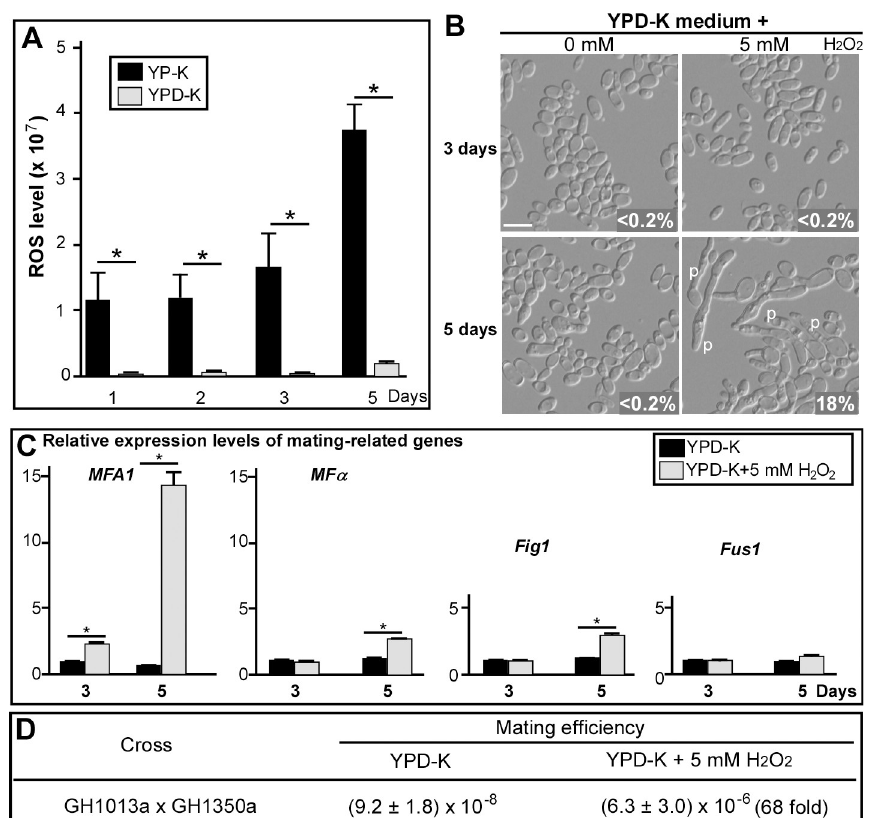
Fig 3. Oxidative stress promotes the development of mating projections in C . albicans . (A) Relative ROS levels. 1 × 10 5 cells of strain GH1013 were spotted on YPD-K and YP-K media and cultured at 25˚C for one, two, three, or five days. For each day, 1 × 10 6 cells were used for ROS level determination. Error bars represent standard deviation of three biological replicates. � indicates significant difference ( p < 0.05, two-tailed Student t test). (B) H 2 O 2 induces the development of mating projections in the presence of glucose. 200 μ L of H 2 O or 5 mM H 2 O 2 solution was spread on YPD-K medium plates (90 mm). 1 × 10 6 cells of strain GH1350a were spotted on the medium and cultured at 25˚C for three or five days. Percentages of projected cells are indicated in the corresponding images. (C) Relative expression levels of mating-related genes in response to H 2 O 2 treatments on YPD-K medium. Error bars, standard errors of technical duplicates. � p < 0.05, two-tailed Student t test. Experiment was performed in biological replicate, and a representative image is shown. (D) Efficiency of same-sex mating on YPD-K medium with or without H 2 O 2 treatment. The mating mixtures were grown on different media at 25˚C for seven days. To make YPD-K + H 2 O 2 plates, 200 μ L H 2 O 2 (5 mM) was spread on the medium surface (of a 90-mm plate). The numerical data are presented in S3 Data . FIG1 , Factor-Induced Gene 1; FUS1 , cell FUSion 1; MFA1 , Mating type A1; MF α , Mating α factor precursor; p, mating projection; ROS, reactive oxidative species; YPD-K, yeast extract-peptone-glucose-K 2 HPO 4 ; YP-K, yeast extract- peptone-K 2 HPO 4